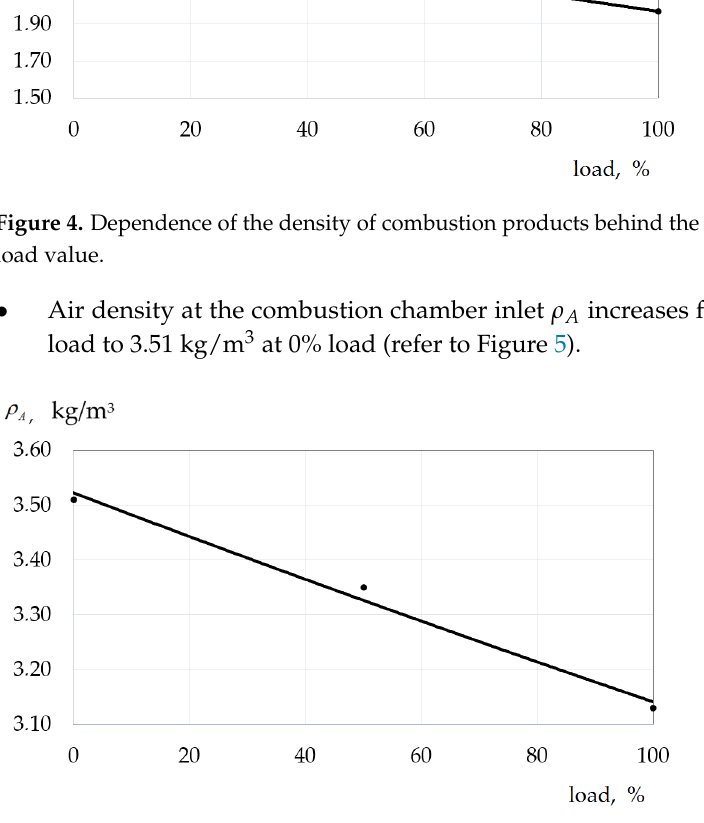
Figure 6. Dependence of the total amount of gases at α s on the load value.